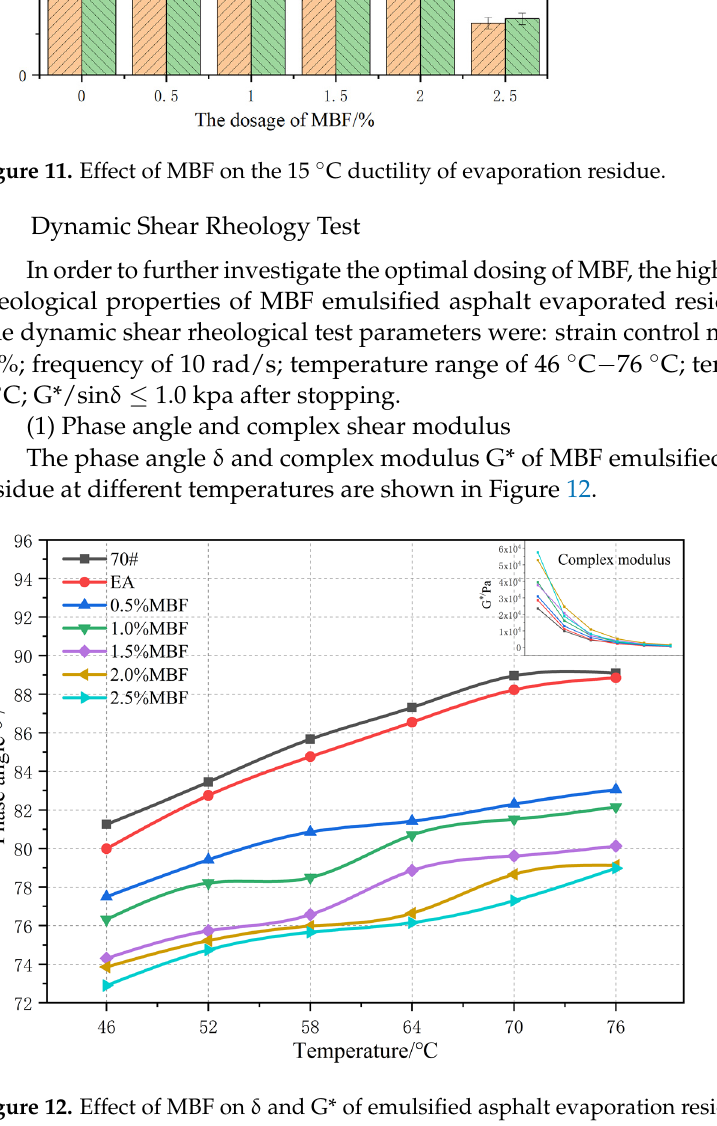
Figure 11. Effect of MBF on the 15 °C ductility of evaporation residue.